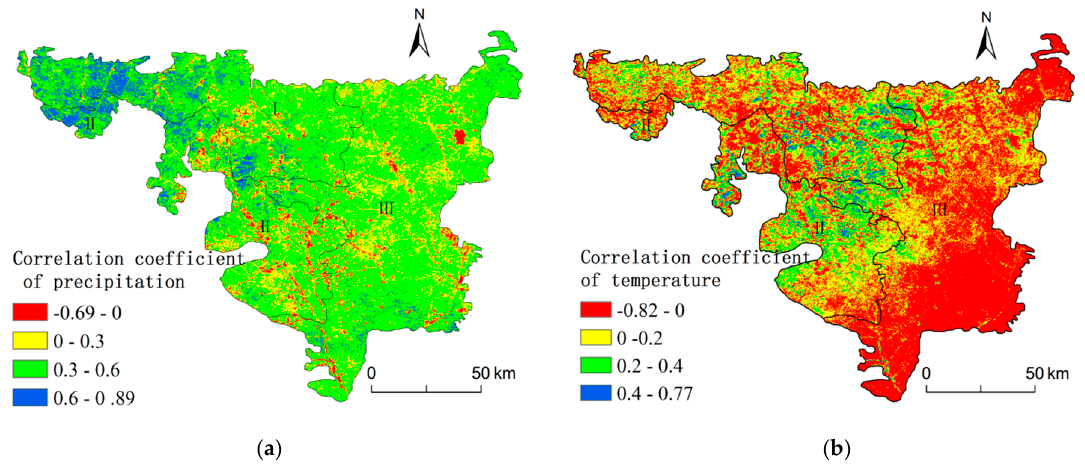
Figure 16. Variations in precipitation and temperature from 2000 to 2019.